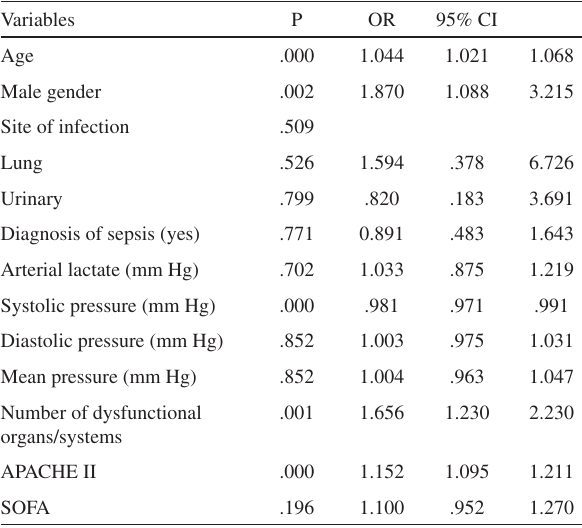
Table 4 - Multivariate analysis of mortality-independent factors